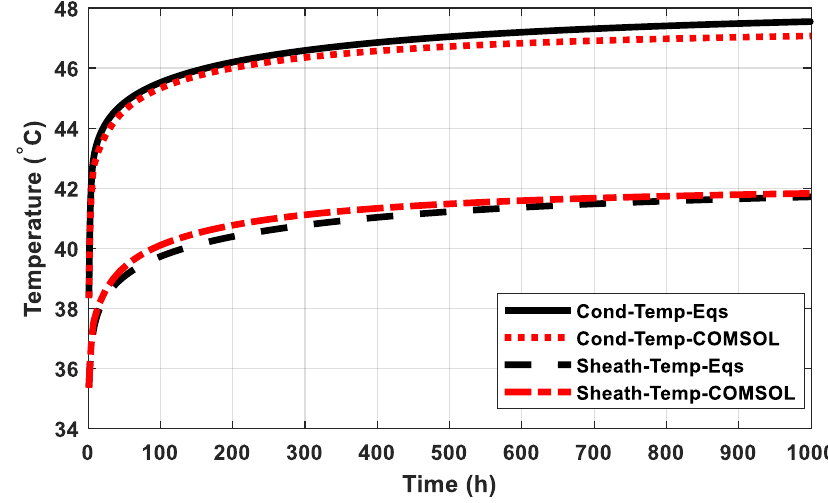
Figure 12. The cable and sheath temperature variation through long duration.